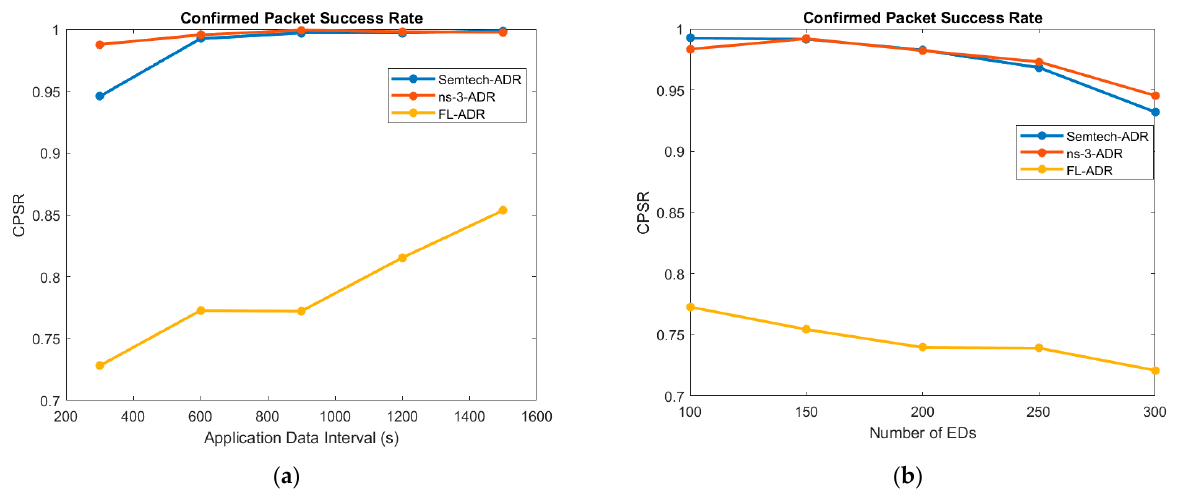
Figure 6. Successful reception rate: ( a ) data interval vs. avg. reception rate/load; ( b ) no. EDs vs. reception rate/load.